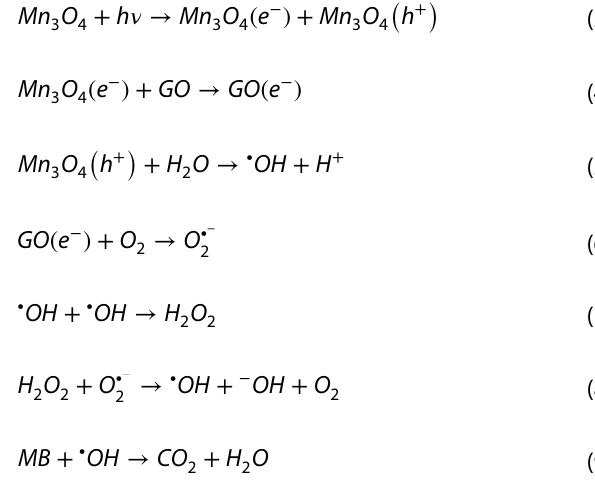
Fig. 12 The % degradation of methylene blue versus time for Mn O NP’s and Mn 3 4